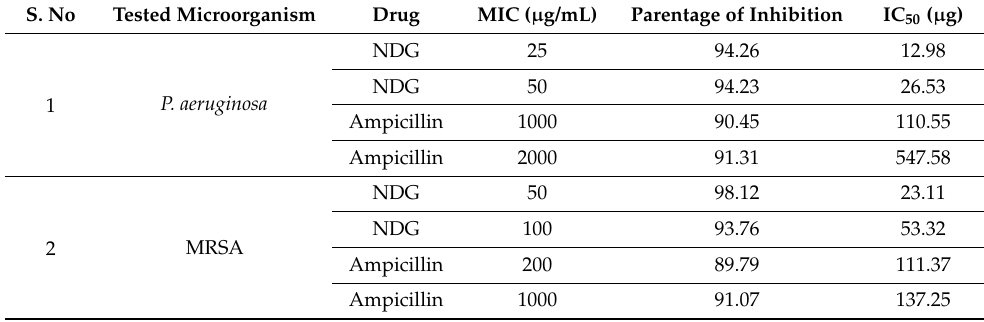
Table 2. Evaluation of MIC, percentage inhibition, and IC 50 values of NDG and Ampicillin.